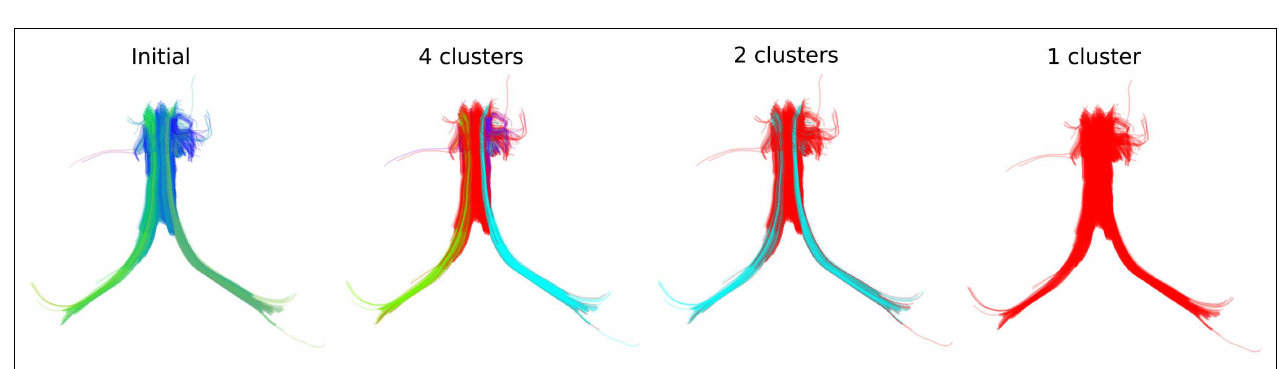
A last cluster (with blue) exposes a shorter part of the Body which is probably due to noise in the data.With a 18mm threshold only two clusters are created. Both Fimbria are brought together as one cluster. A property useful for studies which want to use both Fimbria as one. With a 20mm threshold the entire Fornix is one cluster.This is useful for interactive applications because now the entire Fornix can be described by only one centroid streamline.The streamlines of the Fornix were discretized to have 18